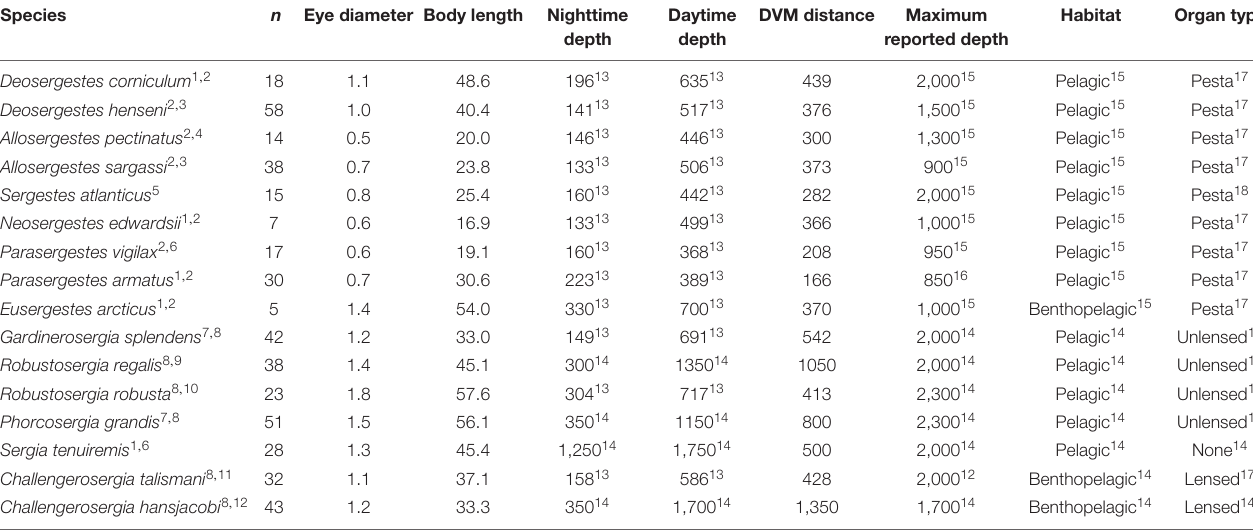
TABLE 1 | Metadata of the study species’ eye diameter, body length, and ecological classifications. Species n Eye diameter Body length Nighttime